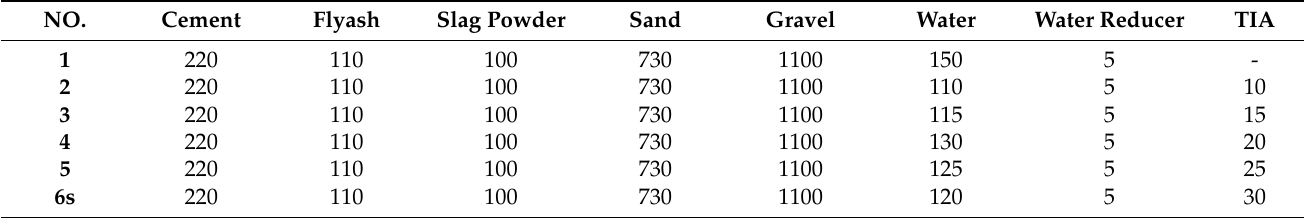
Table 3. Concrete mixture proportions (kg/m 3 ).